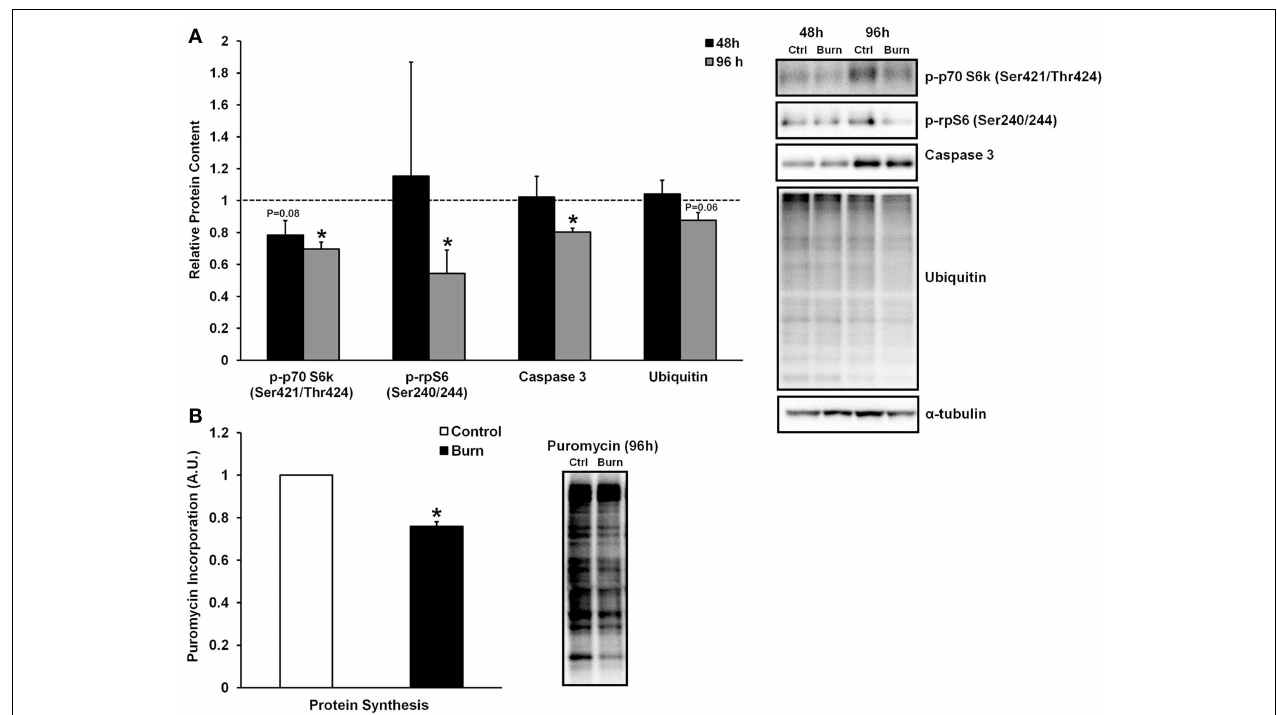
FIGURE 3 | Effects of burn serum on anabolic/catabolic signaling (A) and protein synthesis measured via the SUnSET method (B). ∗ Different from control at respective time point; P < 0 . 05 . Dotted line represents control values.